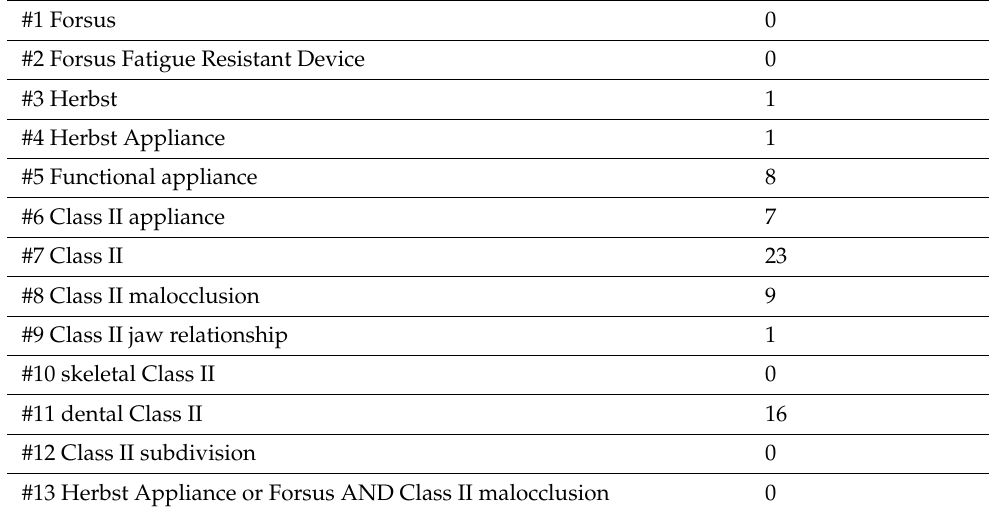
Table A5. Search strategy for Cochrane Oral Health Group’s Trial